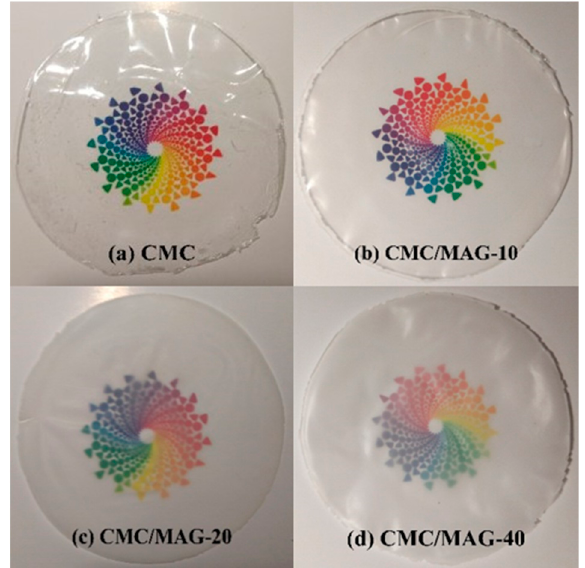
Figure 6. Optical transparency of CMC and CMC/MAG.